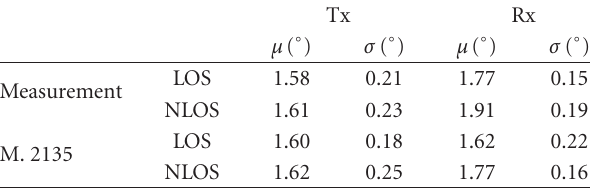
Table 2: Angular